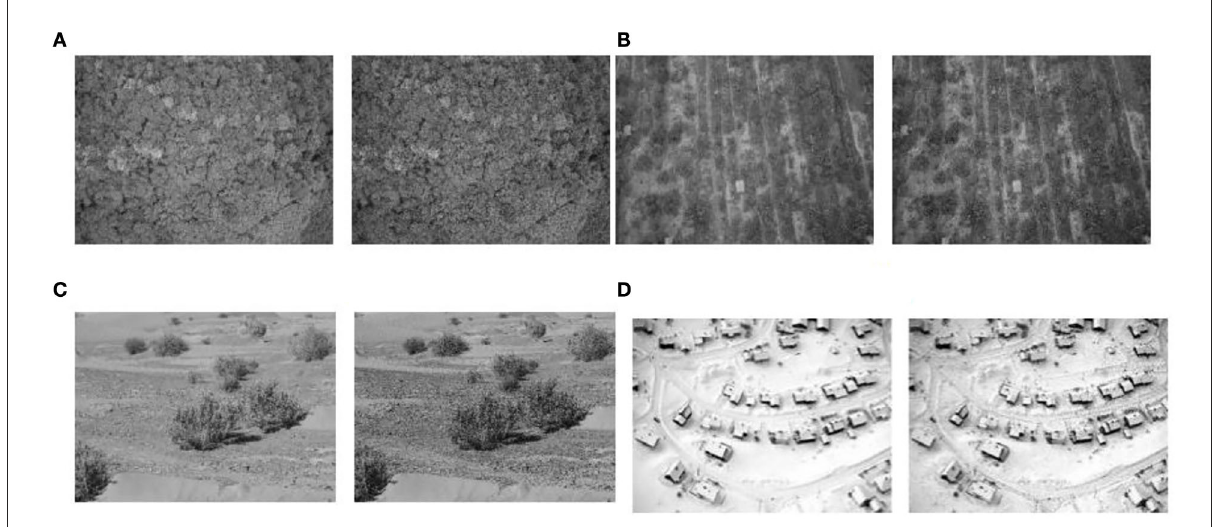
FIGURE8 Comparison of before and after background processing: (A) woodland background; (B) grass background; (C) desert background; and (D) snowy background.